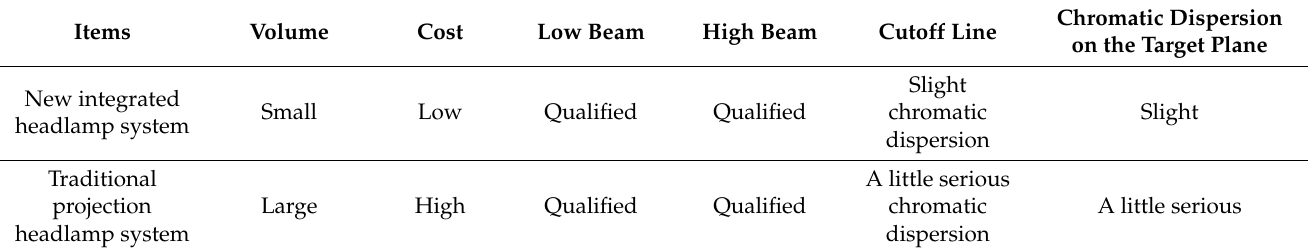
Table 5. The comparison of the new integrated headlamp with traditional